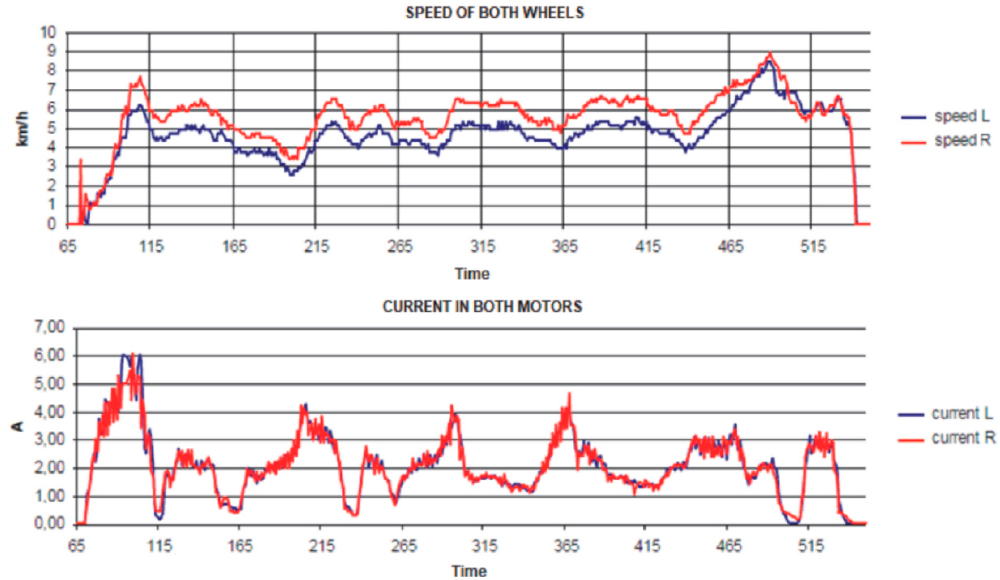
Figure 8. ED control results base exclusively on variation of torque feedback at an average 5 Km/h on a sloping circuit.